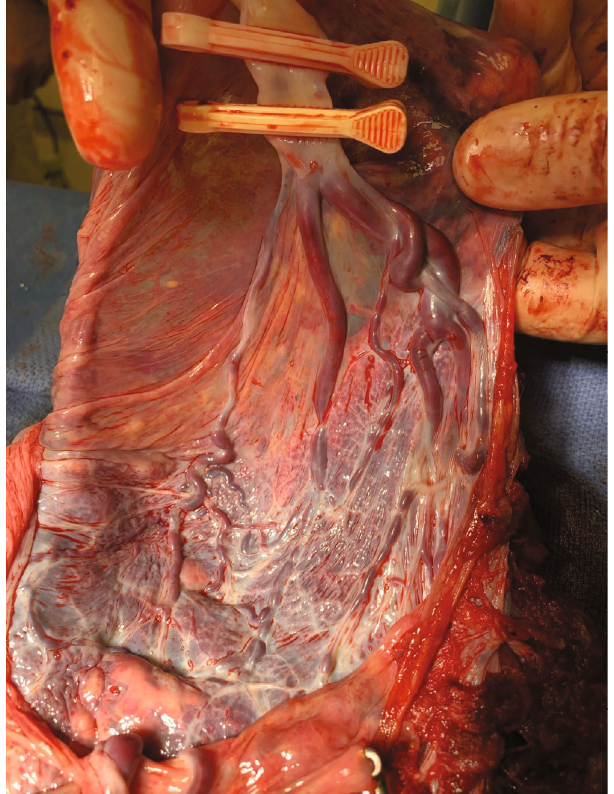
Figure 3: Gross specimen showing vasa previa a ff ecting twin B.